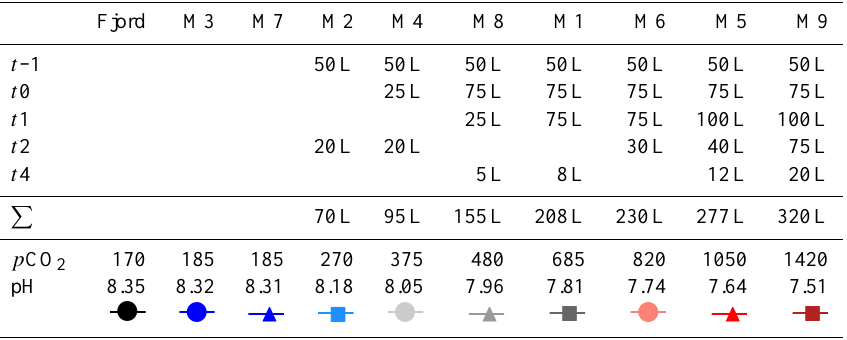
Table 1. Amounts of CO 2 enriched seawater added to the mesocosms between day t –1 and day t 4 . Mesocosms which received no CO 2 addition got 25 l of 50 µm filtered natural seawater instead. Resulting p CO 2 (µatm) and pH (on the total scale) after equilibration with the deadspace are shown as a mean of day t 8 and t 9 values. For comparison initial (day t –3) values for p CO 2 and pH of the fjord are also shown. Symbols and color code denote those used in Figs. 6, 7, 8, 9, 10 and 11.